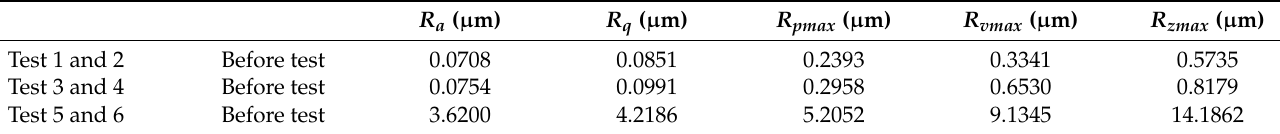
Figure 7. Surface roughness of balls after testing.